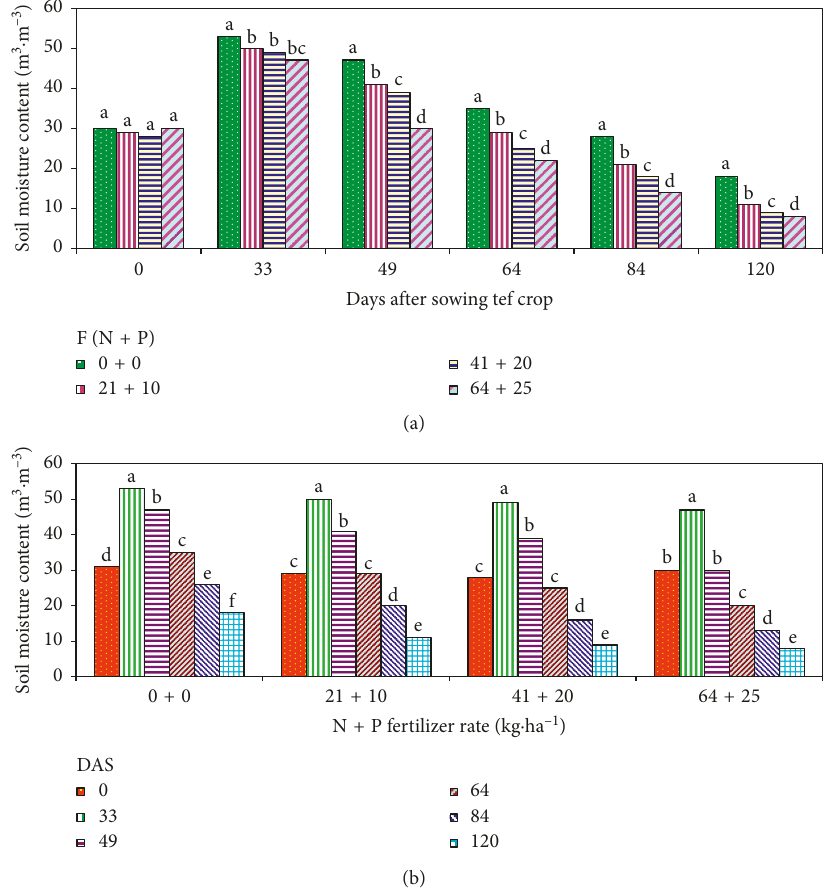
Figure 2: Soil moisture content in the 2012 cropping season affected by (a) fertilizer rates in a given soil sampling date and (b) growth stages (soil sampling dates) for the same fertilizer rate. Note: F (N+P) denotes fertilizer N plus P (kg · ha − 1 ) as 0 N+0 P (F1), 21 N+10 P (F2), 41 N+20 P (F3), and 64 N+25 P (F4); DAS, days after sowing, refers to the soil sampling date to determine